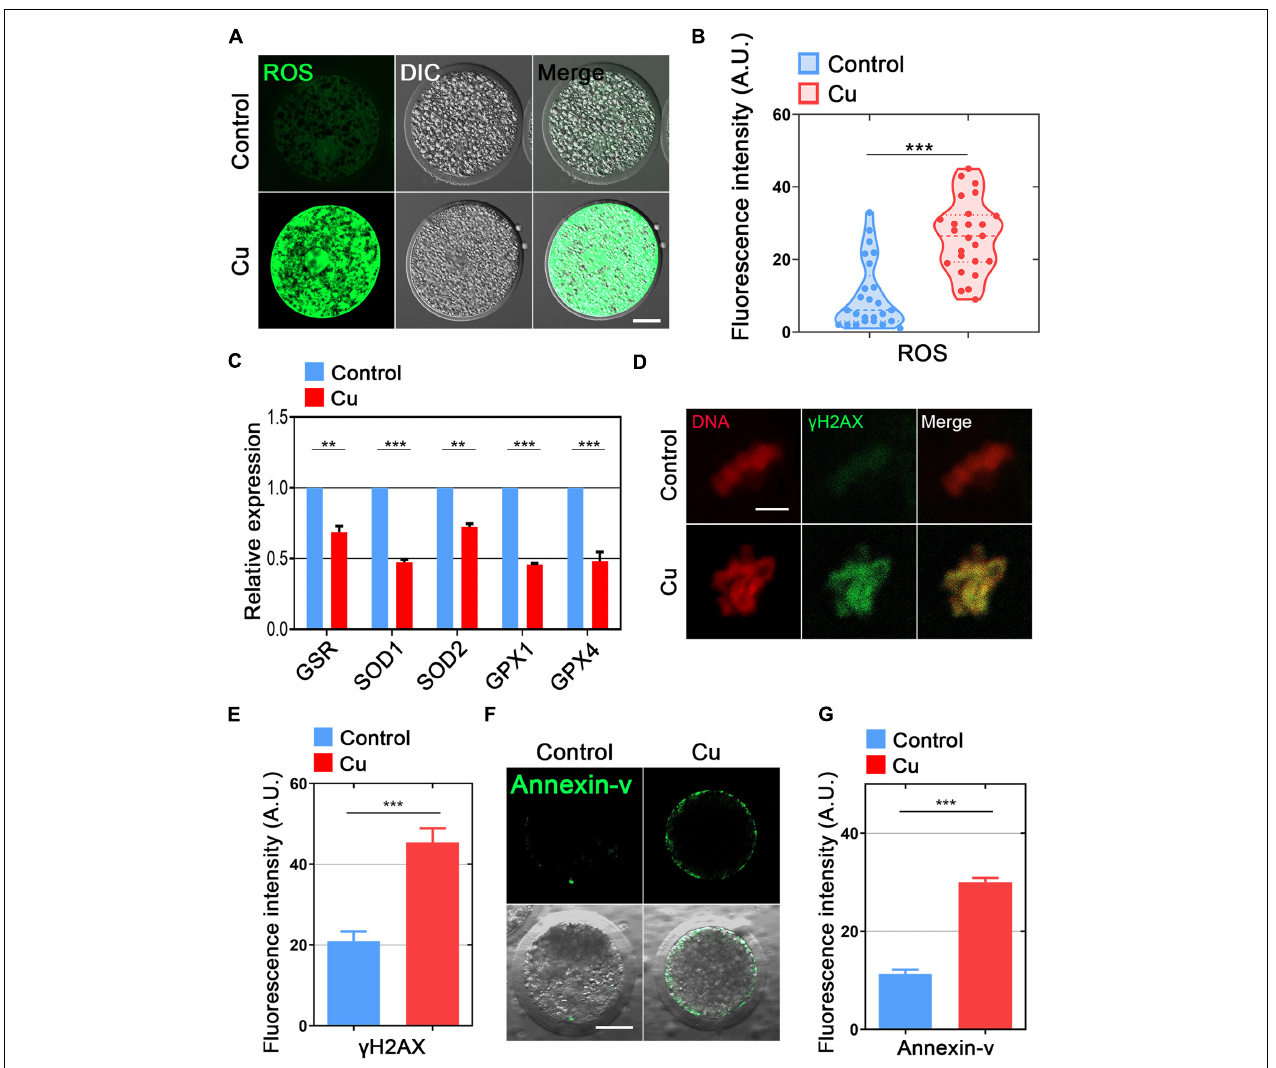
FIGURE 6 | Effects of Cu exposure on the ROS level, DNA damage, and early apoptosis in porcine oocytes. (A) Representative images of ROS signals in the control and Cu-exposed oocytes. Scale bar, 30 µ m. (B) The fluorescence intensity of ROS was quantified in the control and Cu-exposed oocytes. (C) The expression of genes related to the anti-oxidation pathway was examined in the control and Cu-exposed oocytes. (D) The representative images of DNA damage in the control and Cu-exposed oocytes. Scale bar, 5 µ m. (E) The fluorescence intensity of γ H2A.X signals was quantified in the control and Cu-exposed oocytes. (F) The representative images of apoptotic oocytes were shown in the control and Cu-exposed oocytes. Scale bar, 30 in the control and Cu-exposed oocytes. Data of (B,C,E,G) were expressed as the mean percentage of at least three independent experiments (mean ± SEM). ** P < 0.01, *** P <